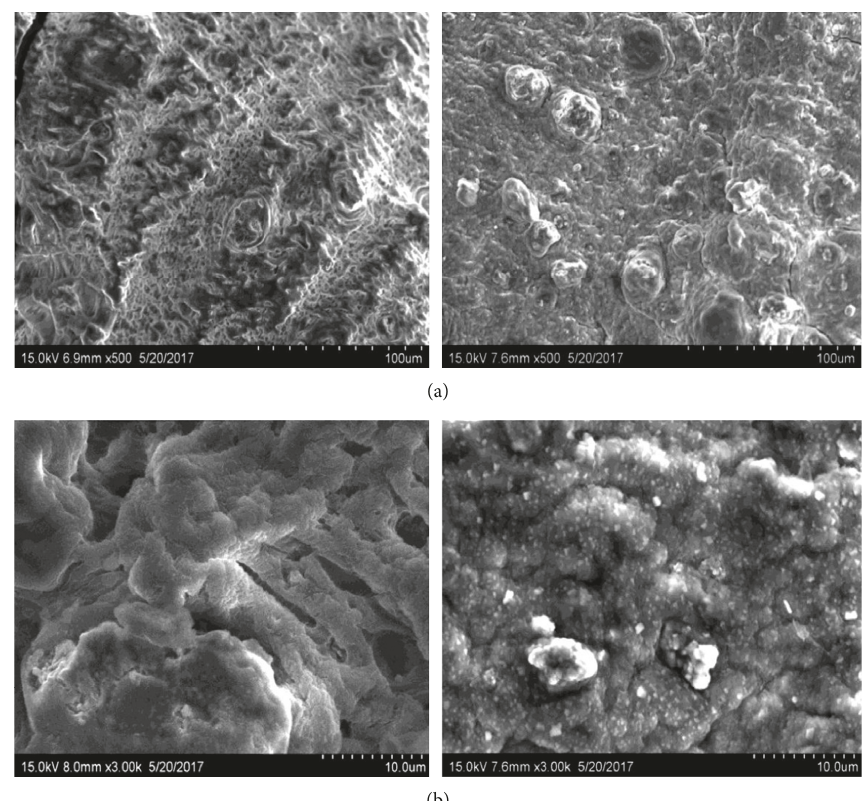
Figure 2: SEM images of adsorbent (HRMCAB). (a) SEM images of adsorbent before (left) and after (right) lead adsorption at 500x resolution. (b) SEM images of adsorbent before (left) and after (after) lead adsorption at 3000x resolution.